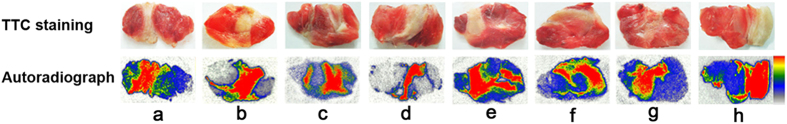
TTC staining images and autoradiographs of eight tracers from mice sacrificed 24 h after administration.On the TTC-stained images, the necrotic muscles remained pale whereas normal muscles were stained brick red. The high radioactivity uptakes (in red) primarily appeared in necrotic regions on autoradiograms, which were in accordance with pale areas on TTC staining images. (a–h) were represented 131I-1-hydroxyanthraquinone, 131I-alizarin, 131I-danthron, 131I-rhein, 131I-aloe-emodin, 131I-chrysophanol, 131I-emodin and 131I-physcion, respectively.